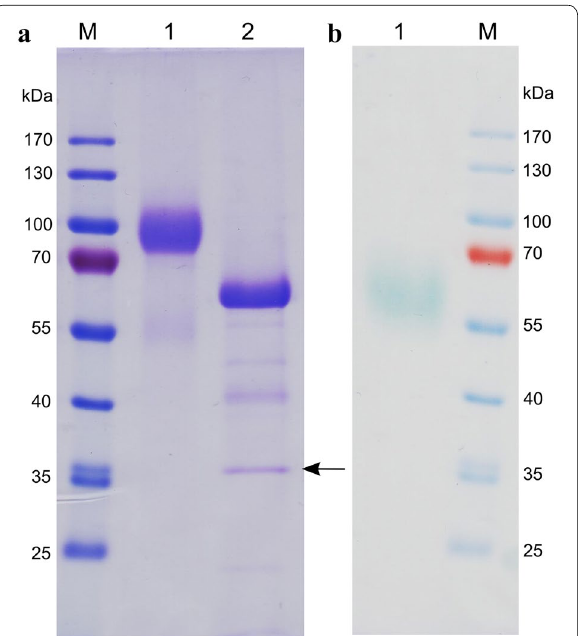
Fig. 1 12.5% SDS‑PAGE of Mrl2 purification. 5 µg total protein was loaded in each lane ; M pre‑stained protein markers; a Coomassie staining; 1 Mrl2 after DEAE FF purification, 2 Mrl2 after DEAE FF purifi‑ cation and PNGase F (indicated by an arrow ) treatment, b zymogram with ABTS 1 purified Mrl2